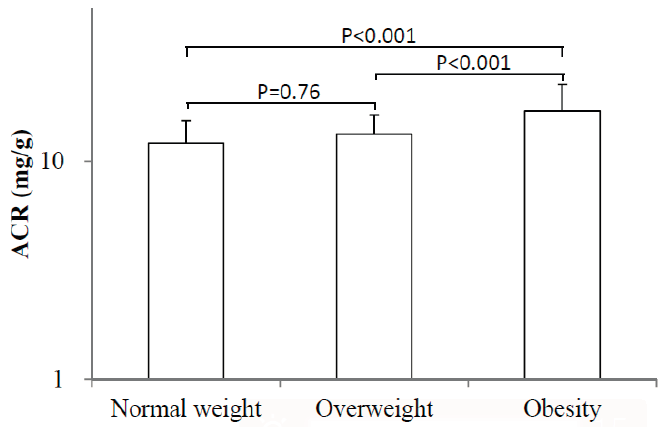
Figure 1. Comparision of ACR values among hypertensive patients with normal